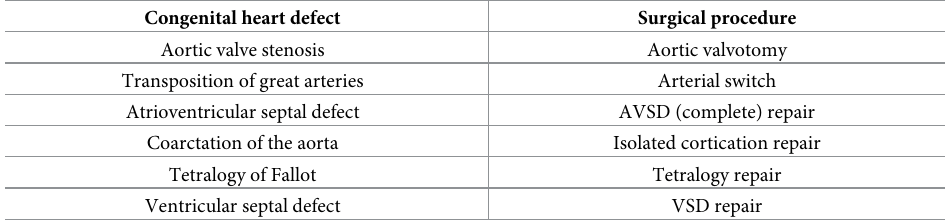
Table 1. Congenital heart defects and most common surgical procedures involving use of patches.